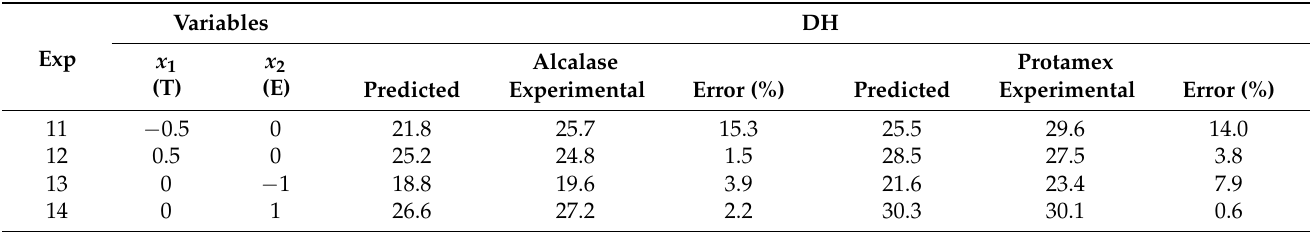
Figure 4. Predicted and experimental hydrolysis curves for the hydrolysis of milk proteins with Alcalase. Experimental data (circles), predicted curves (continuous line) and confidence interval of predicted curves at 95% probability (dashed lines) for experiments presented in Table 6. Table 7. Predicted and experimental values for DH after 60 min of milk protein hydrolysis from validation experiments with Alcalase and